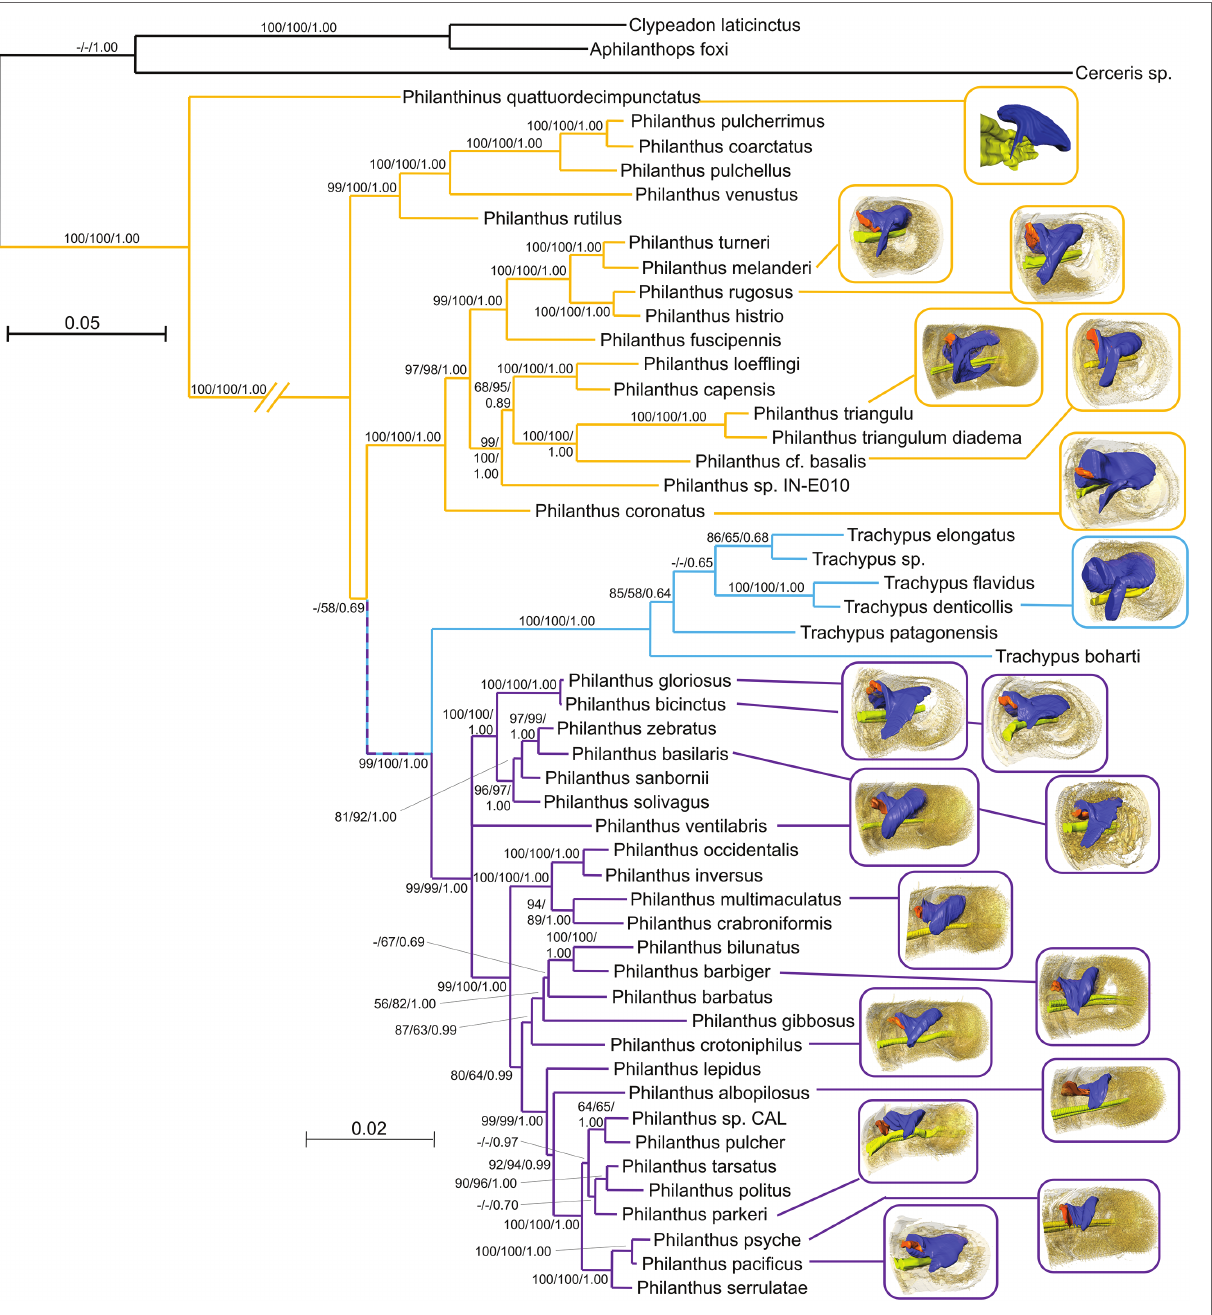
FIGURE 4 | Mapping of the available 3D reconstructions onto a phylogenetic tree of the Philanthinae. Yellow lines link European/African/Asian species, Light blue lines link South American species, and Lilac lines link North American species. Node values represent bootstraps from PAUP*, RAxML, and posterior probabilities from MrBayes, respectively (for details, see Kaltenpoth et al.,